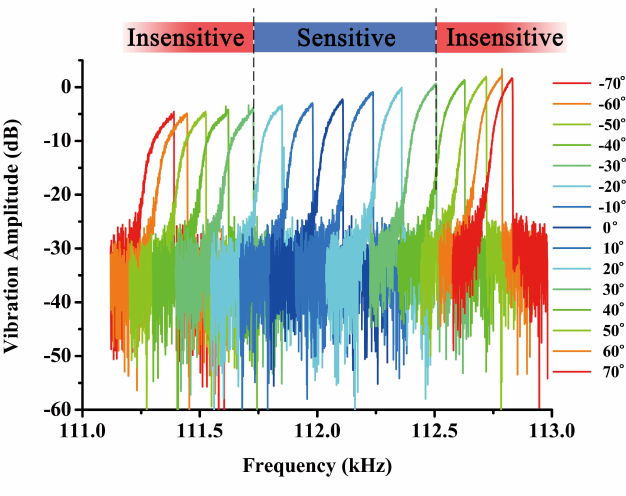
Figure 7. Open-loop test result of DETF B from − 50 ◦ to 50 ◦